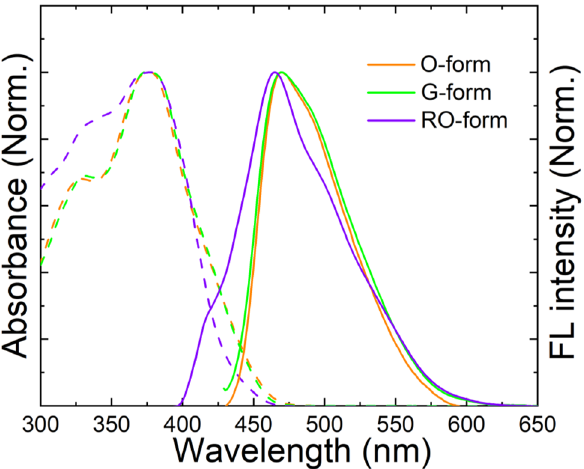
Figure 7. UV–visible absorption and FL emission spectra of O-, G- and RO-forms in solution (1.0 × 10 ‒ 6 M in CHCl 3 , excited at 365